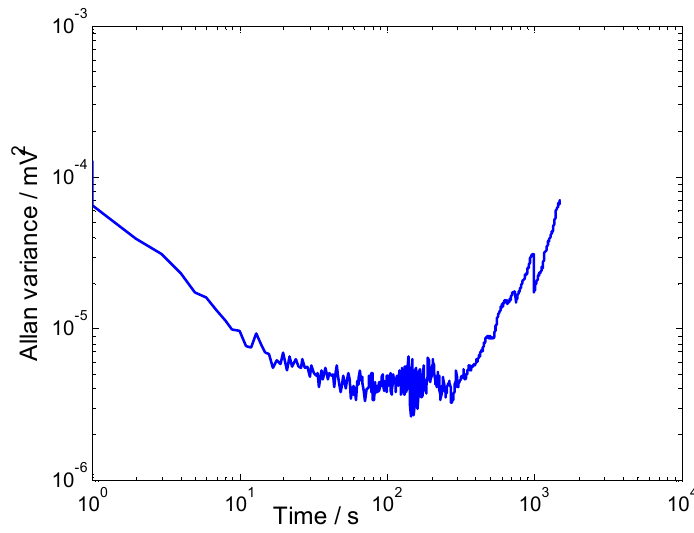
Figure 9. Allan variance analysis of the detection system. To perform the measurement precision analysis, the pure SF6 gas was measured 50 times continuously. The measured results were plotted in a column graph, as shown in Figure 10. The horizontal axis represents the PA signal range, and the vertical axis represents the frequency count. Then, the graph was fitted with a Gaussian profile. The expected value of the Gaussian distribution is 0.962 mV, the standard deviation is 5.98 µ V, and the half-width at half maximum (HWHM) is 7.05 µ V.